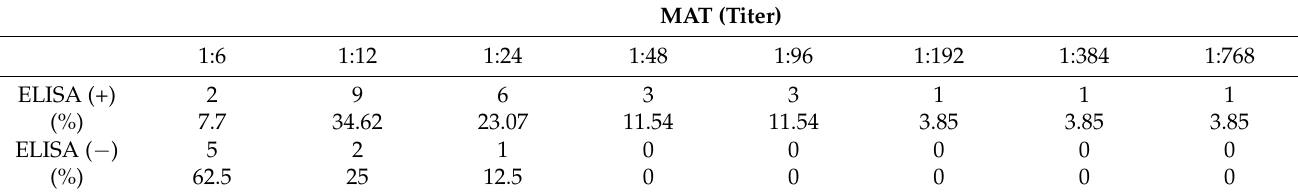
Table 2. MAT titers of ELISA positive dog sera ( n = 26) and ELISA negative but MAT positive ( n = 8).